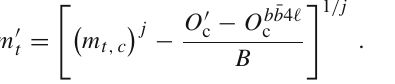
columns three and four. Their α S uncertainties, computed as described in Sect. 6.1.3 are displayed in column five. The statistical errors are also reported, except for the scale and PDF variations, where they have been estimated to be below 13% of the quoted